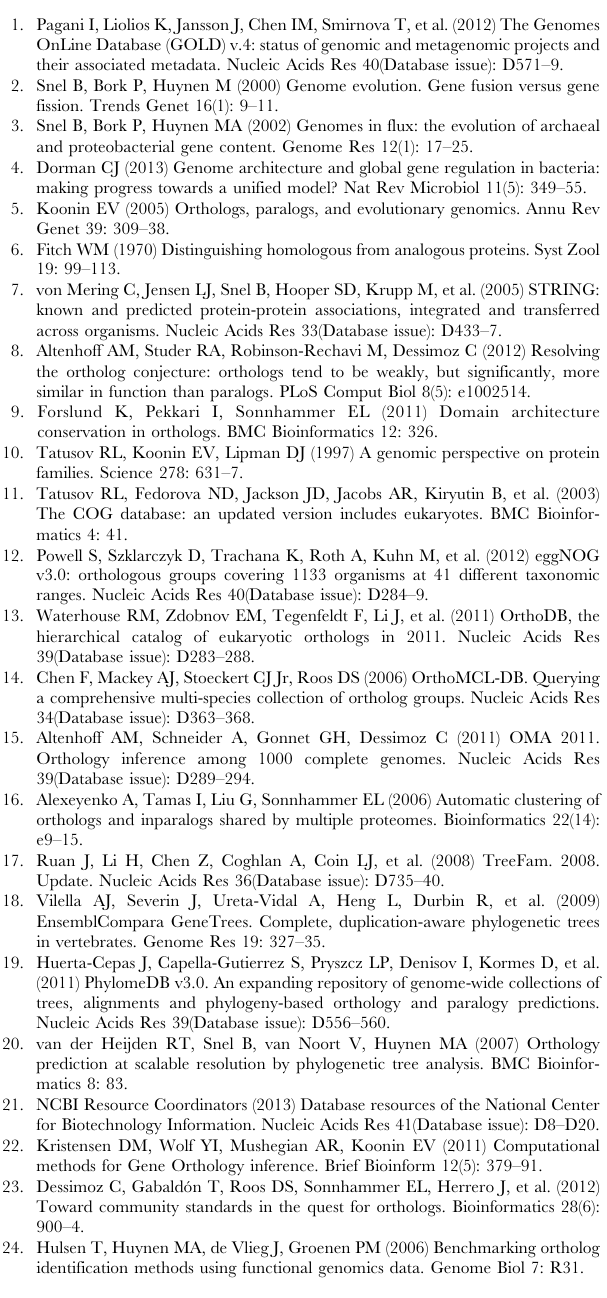
Table S8 , Table of the error distribution of each species at the gene- and